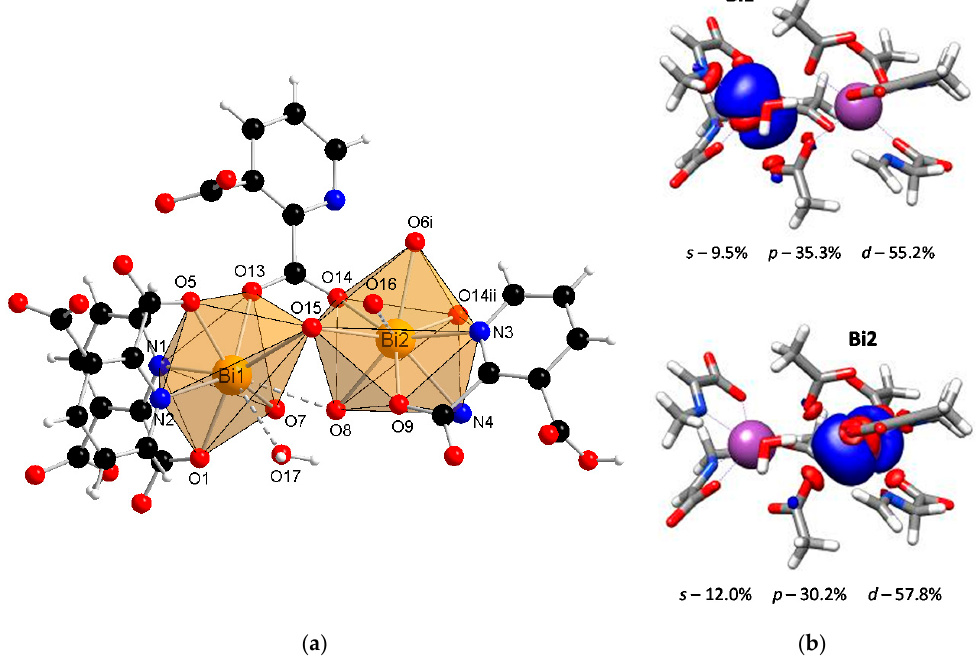
Figure 1. ( a ) The molecular structure with an atom numbering scheme of complex 1 (Symmetry codes: (i) − x, 1 − y, 1 − z; (ii) 1 − x, 1 − y, 1 − z) (Bi—orange, O—red, N—blue, C—black, H—white); ( b ) graphical representation of selected molecular orbital localized on Bi atom in complex 1 (DFT